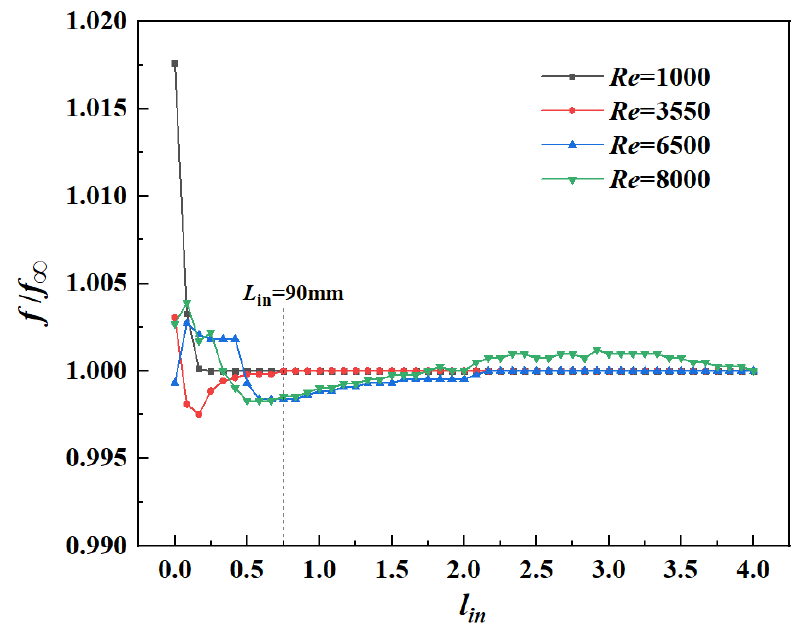
Figure 7. Variation in the normalized friction factor with the length of the inlet section.